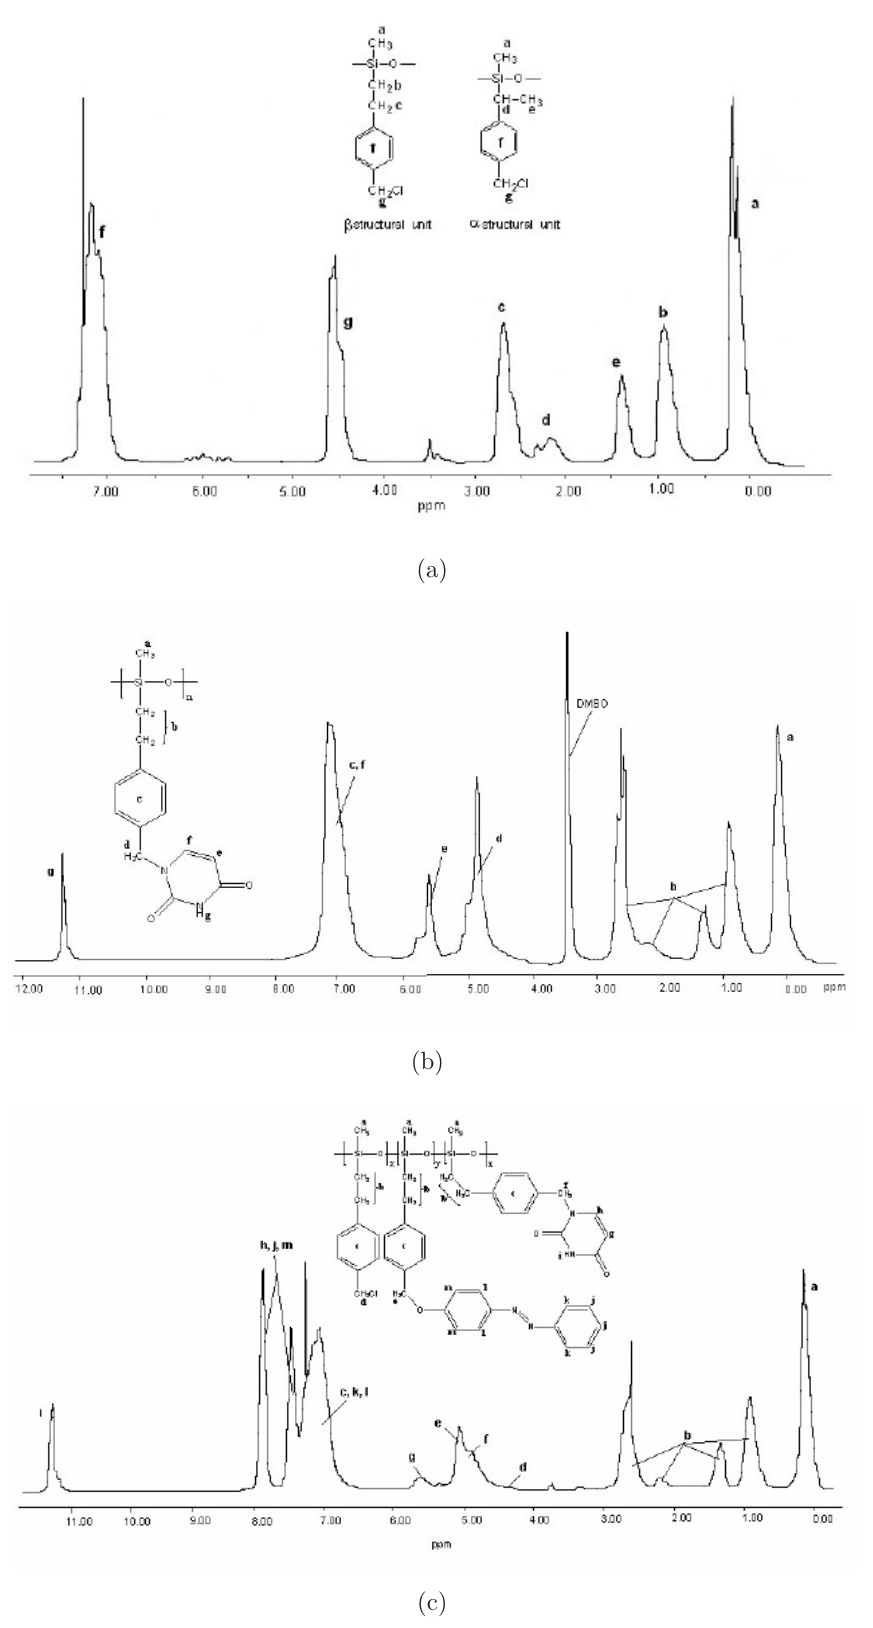
Fig. 3 1 H-NMR spectra of un-substituted polysiloxane in CDCl 3 (A), substituted with uracil in DMSO (B) and substituted with azobenzene and uracil in CDCl 3